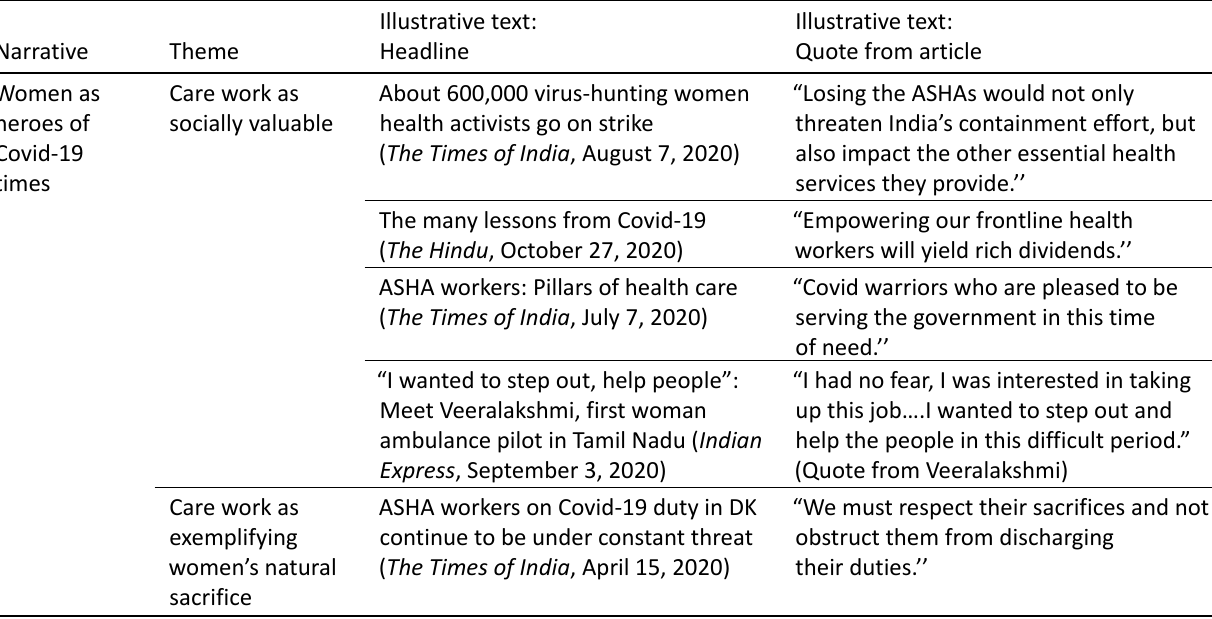
Table 1. (Cont.) Main narrative threads and illustrative extracts from articles